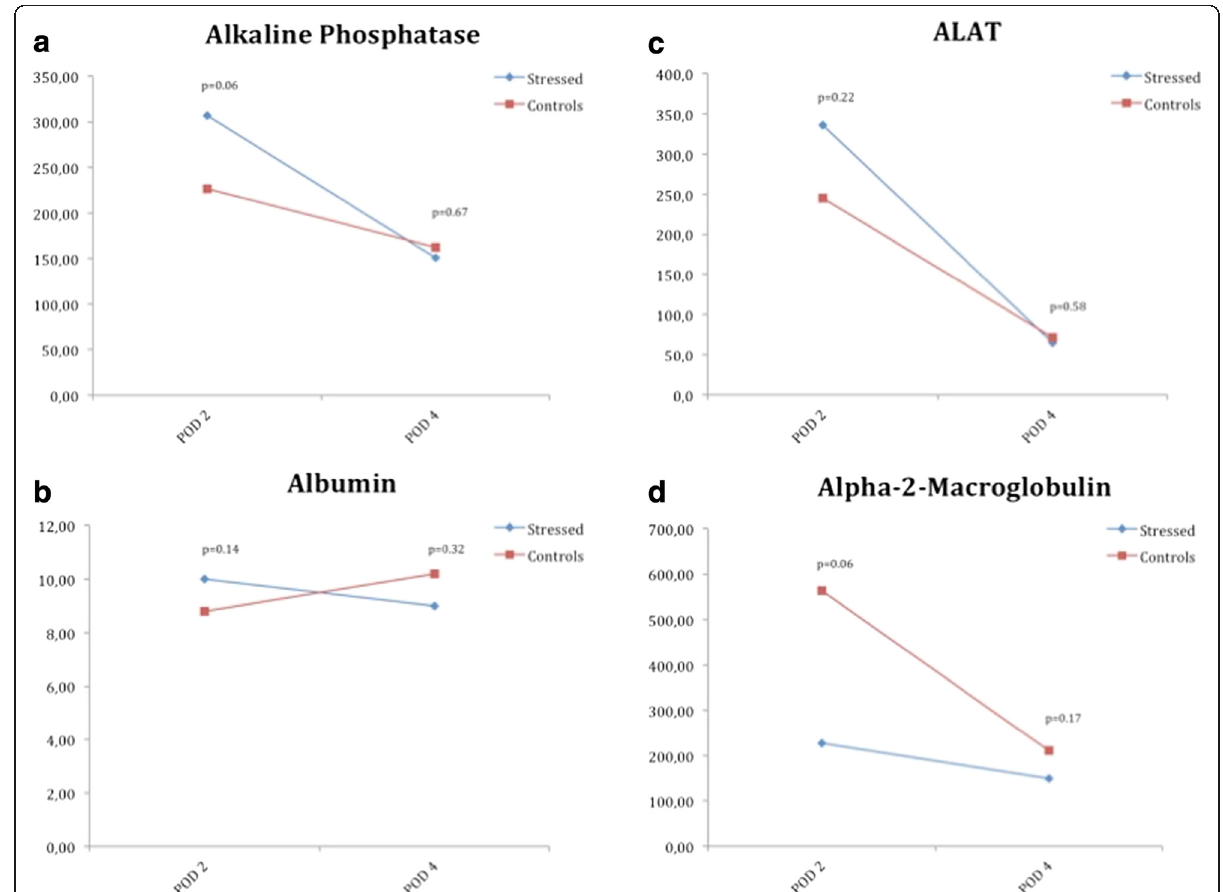
Fig. 6 Biochemical markers. Mean alkaline phosphatase ( a ), bilirubin ( b ), alanine aminotransferase ( c ), and alpha-2-macroglobulin ( d ) for each group of animals. The blue line marks the treatment group and the red line marks the control